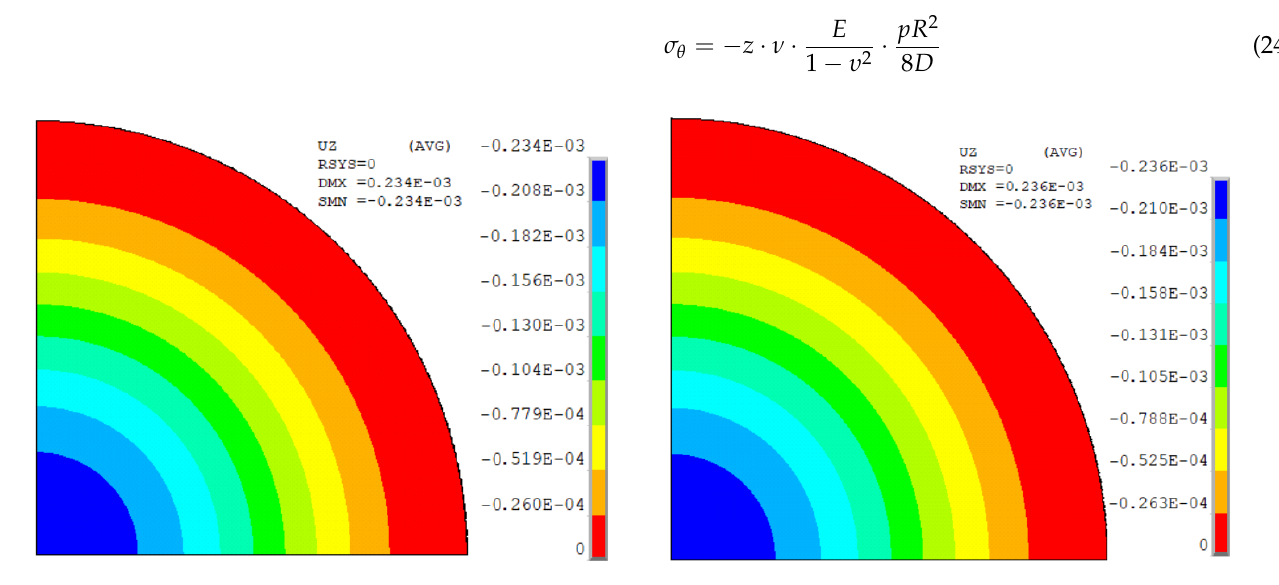
Figure 15. Transversal displacements field of FGP.